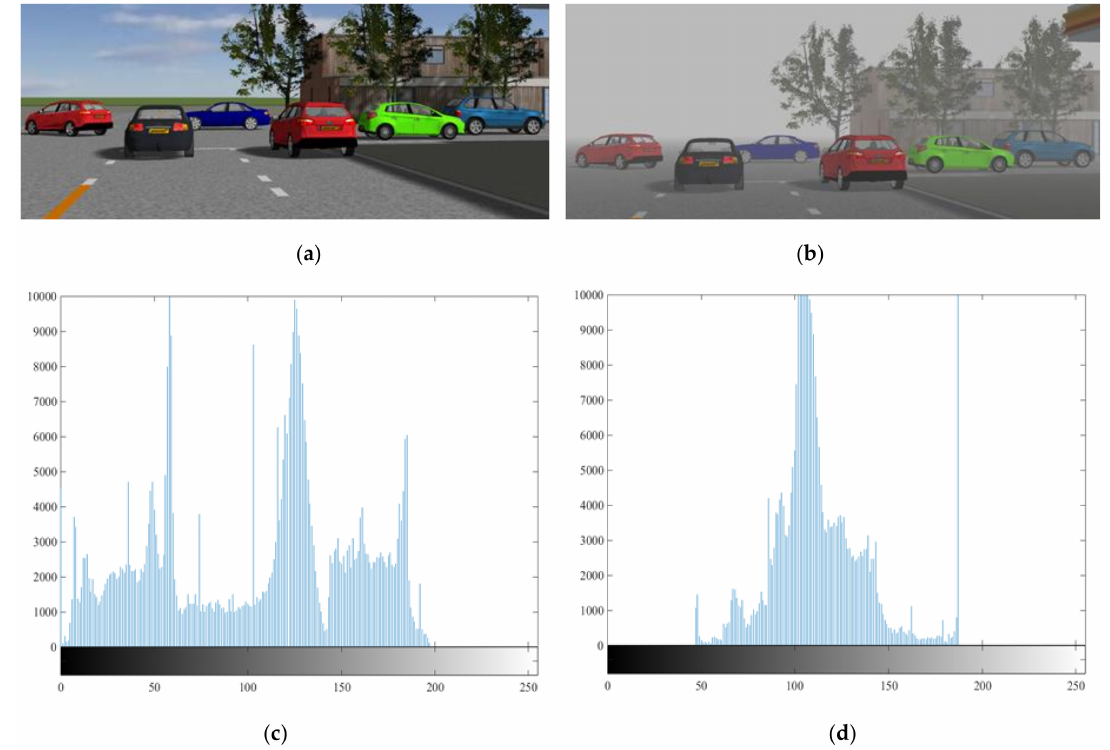
Figure 2. This is a contrast between the image of the weather and the grayscale of the foggy image, in which ( a ) is the image of sunny day, ( b ) is the image in visibility of 200 m of fog day, ( c ) is the grayscale of sunny day image, and ( d ) is the grayscale of fog day image.